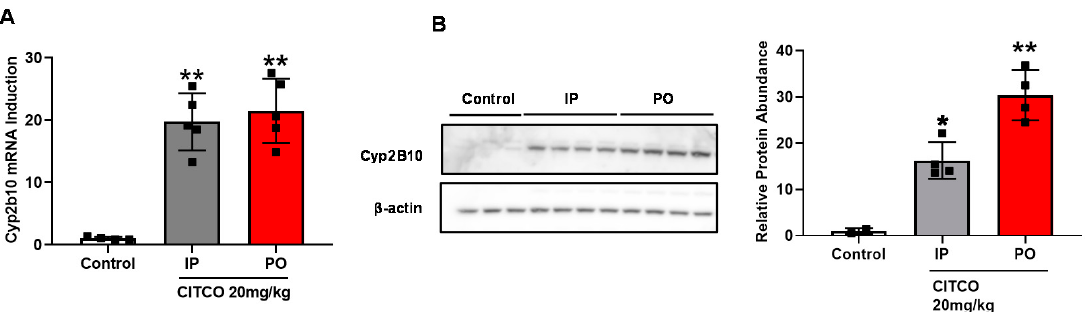
Figure 4. Oral administration of CITCO effectively induces hepatic expression of CYP2B10. hCAR- TG-mice were treated with vehicle control (corn oil) or CITCO at 20 mg/kg via IP or PO as detailed inSection 2. Expression of Cyp2b10 in the liver was measured by RT-PCAR ( A ) and Western blotting ( B ). Data represent the mean ± SD, n = 4–5. *, p < 0.05; **, p < 0.01.